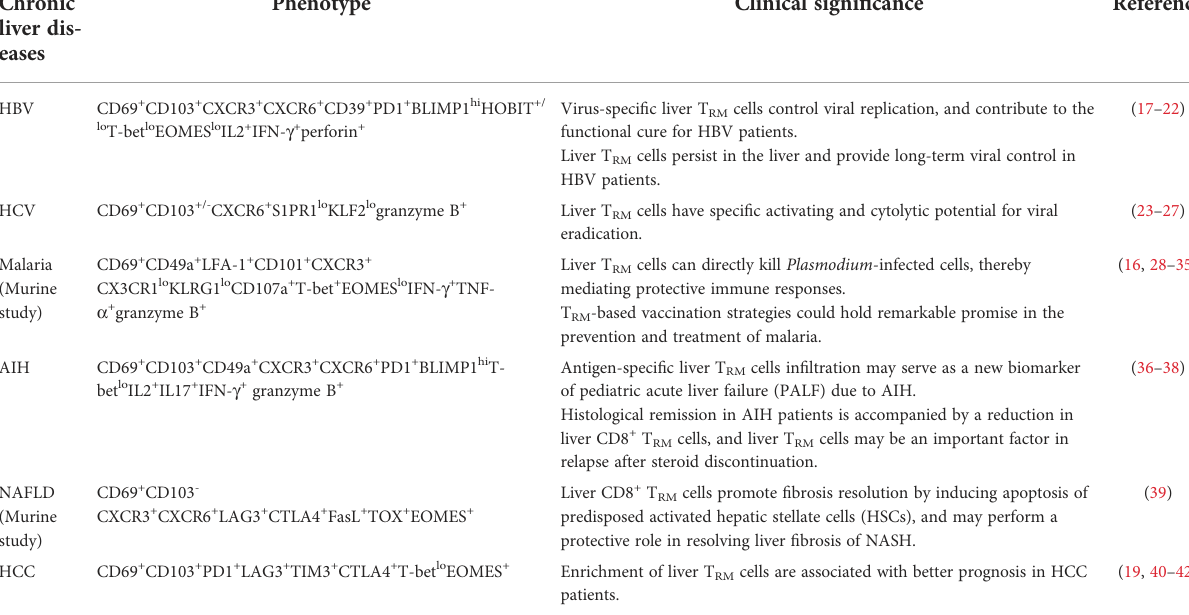
TABLE 1 Phenotype and clinical signi fi cance of liver CD8+ TRM cells in chronic liver diseases.